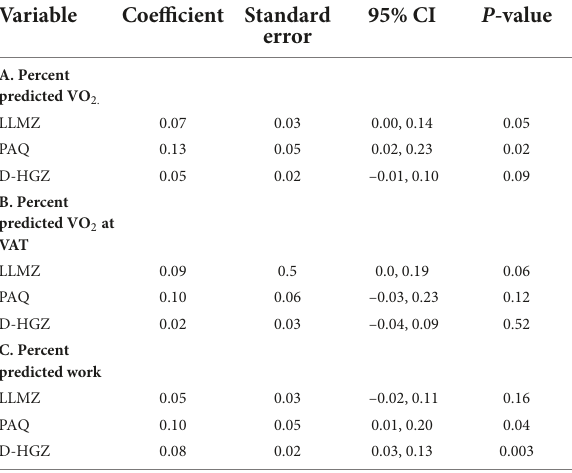
TABLE 5 Results from multiple linear regression models testing effect of skeletal muscle and physical activity variables on exercise